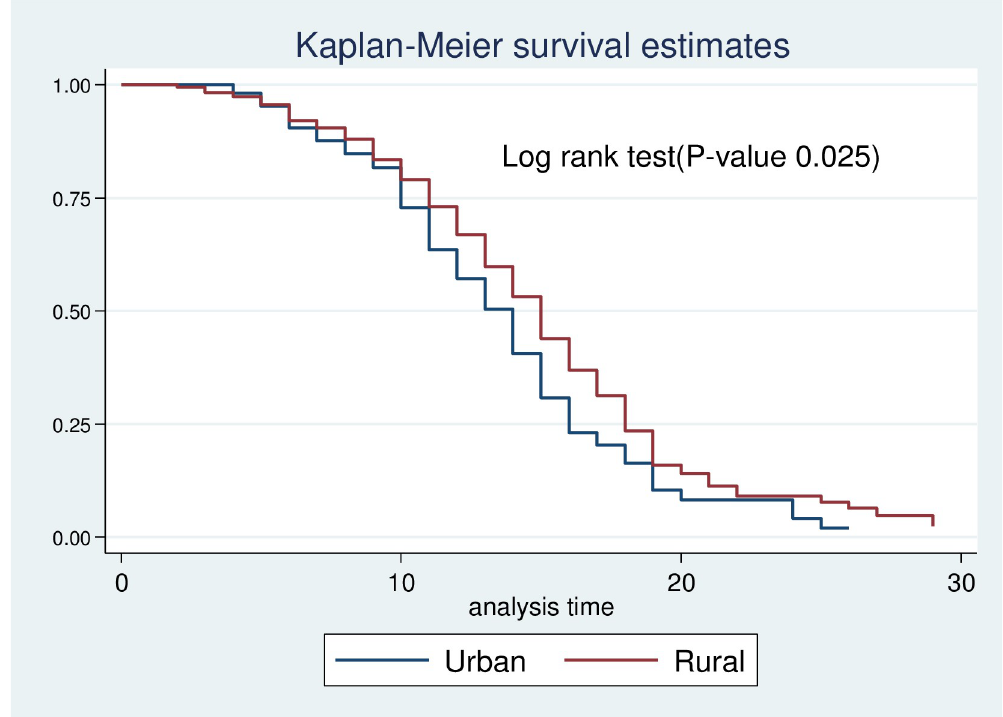
Fig 3. Log-rank survival estimate for time to recovery of SAM children by